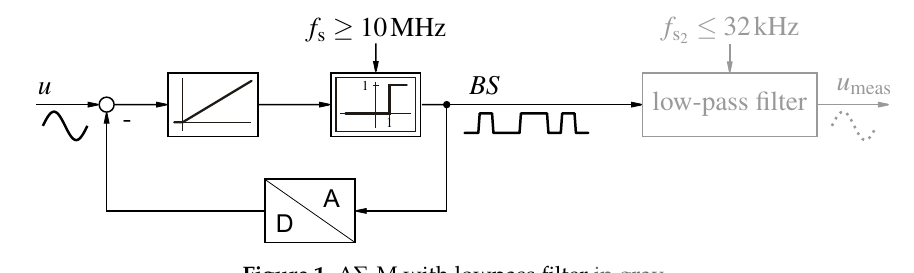
Figure 1. ∆Σ -M with lowpass filter in